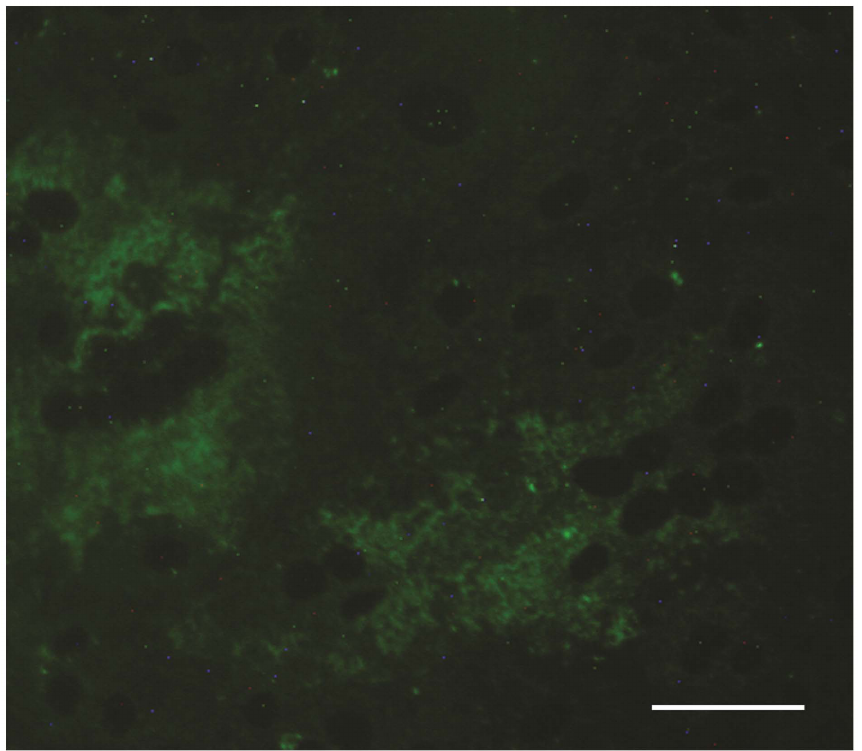
Figure 4. Indirect immunofluorescence (IIF) for detection IgM antibodies performed on the serum sample of wolf W1. Scale bar=100 m m.